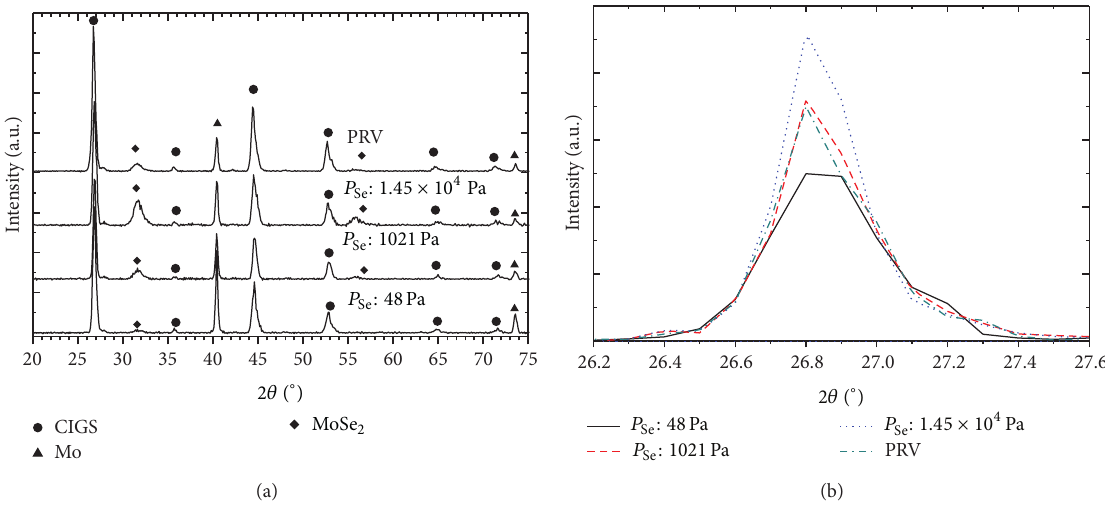
Figure 3: XRD patterns with various selenization pressures: (a) CIGS/MoSe 2 /Mo films and (b) (112) peak of CIGS films.